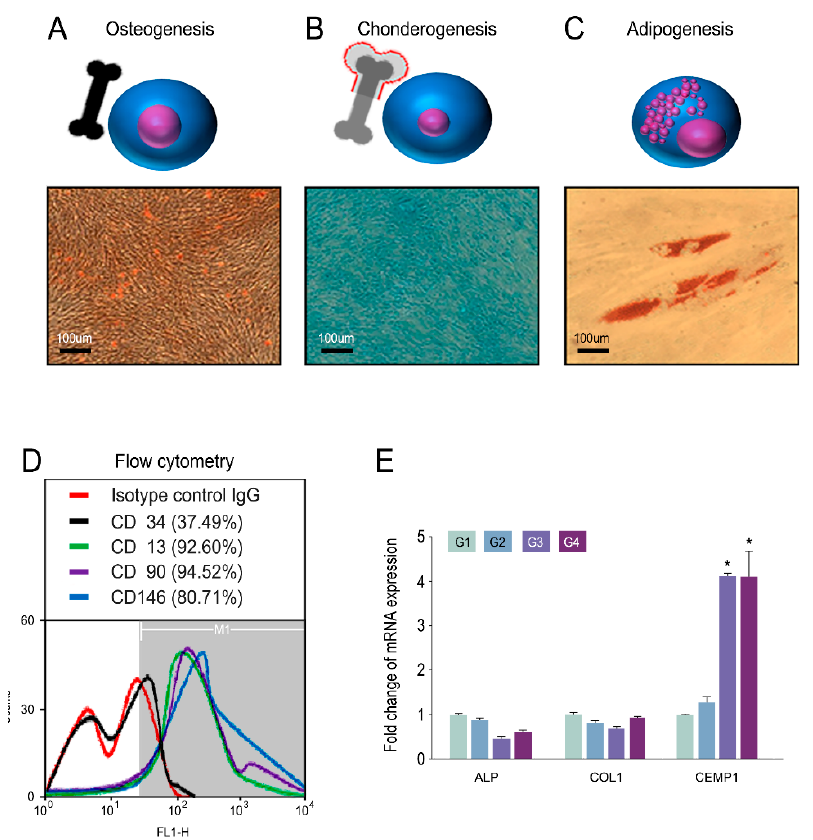
Figure 1. Cell characterization of hPDLSCs. ( A – C ) Tripotent lineage of hPDLSCs. ( A ) Alizarin red S staining for osteogenesis; ( B ) Alcian blue staining for chondrogenesis; ( C ) Oil red O staining for adipogenesis; ( D ) flow cytometry using mesenchymal stem cell markers CD34, CD13, CD90, and CD146; ( E ) quantitative PCR analysis of hPDLSCs in titanium scaffold at 7 d after cell seeding or bioprinting. * p < 0.05.